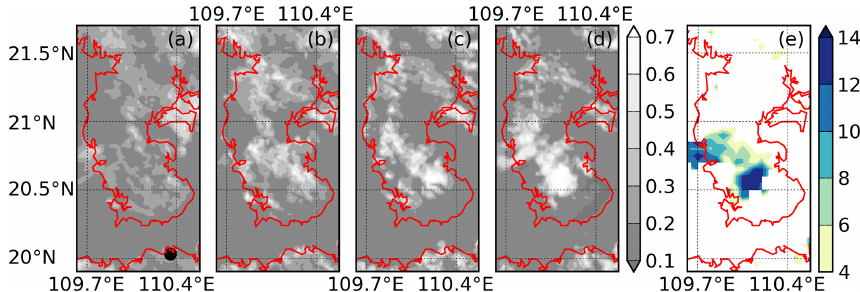
Figure 1. Observed albedo at the wavelength of 0.47µm and at (a) 11:00, (b) 12:00, (c) 13:00, and (d) 14:00 LST, 25 September 2018. (e) Retrieved cloud-top height (km) at 14:00LST. The black dot in panel (a) indicates the location of Haikou station, where the sounding was obtained.